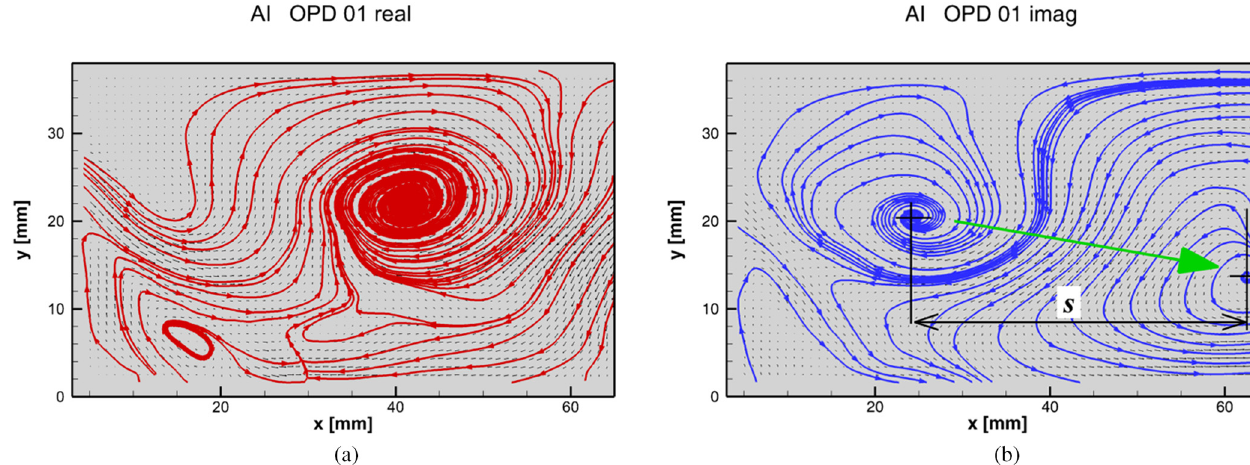
Fig. 11. Topology of the OPD mode no. 1 in the branch A, zone I, real (a) and imaginary (b) parts.